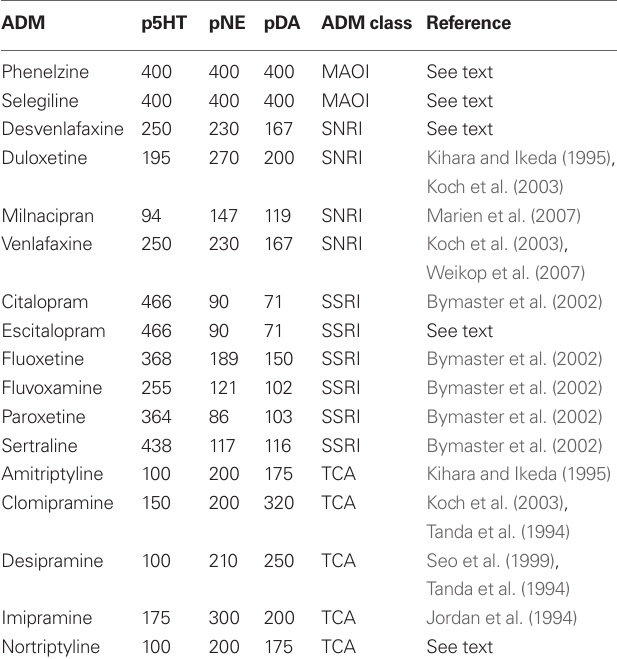
Table 1 | Perturbational effects of antidepressants on mPFC levels of monoamine neurotransmitters (expressed as percent over